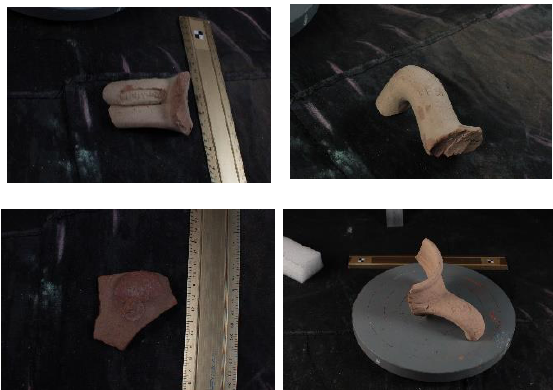
Figure 3. Stamped handles from Kos, Rhodes, Chios and Knidos (from top